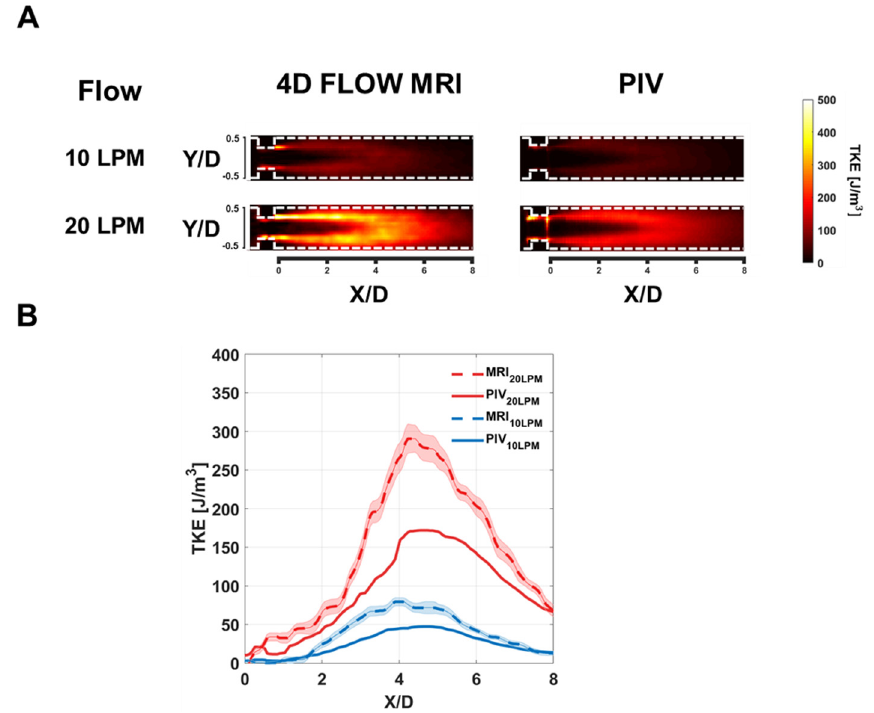
Figure 4. Turbulence kinetic energy (TKE) through the stenosis. ( A ) TKE contours. ( B ) Centerline TKE.